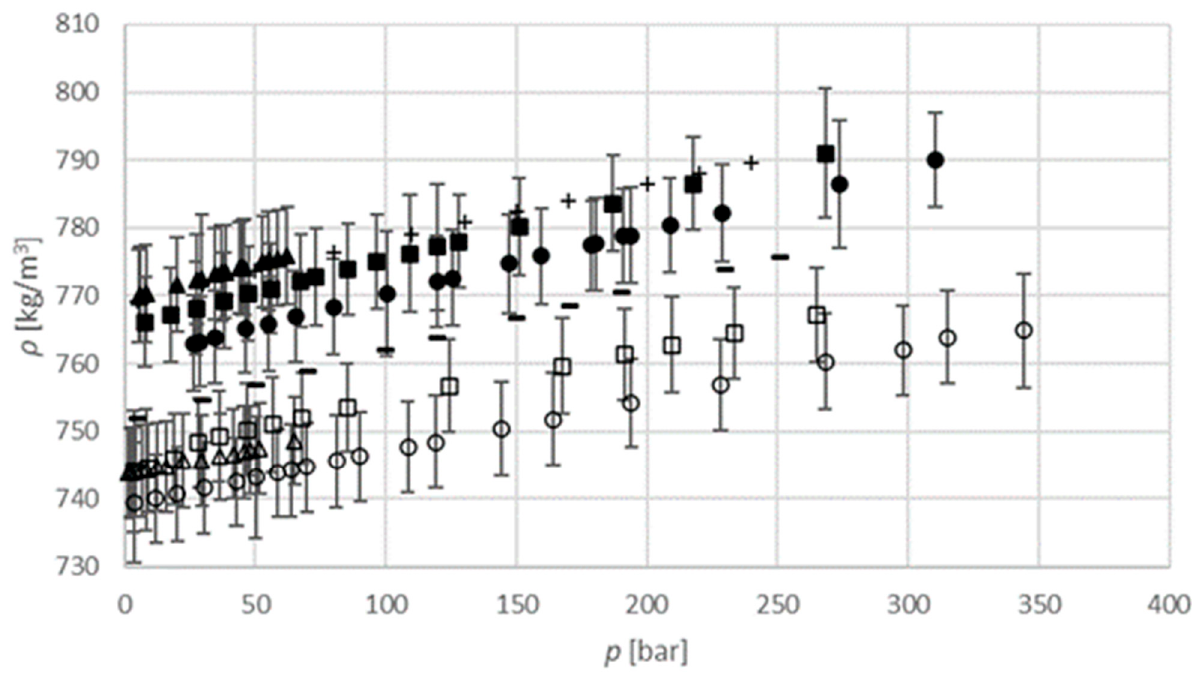
Figure 7. Densities: Figure 4. The viscosity of pure gas as a function of pressure in comparison to literature data: , , measured data CO 2 saturated isopropanol at 313.15 K; Figure 7. Densities: , measured data CO 2 saturated isopropanol at 313.15 K; , measured data , measured data CO 2 Figure 4. The viscosity of pure gas as a function of pressure in comparison to literature data: , Figure 7. Densities: , measured data CO 2 saturated isopropanol at 313.15 K; , measured data Figure 7. Densities: , measured data CO 2 saturated isopropanol at 313.15 K; , measured data measured data at 313.15 K; , measured data at 333.15 K; X, pure gas at 313.15 K [16]; , pure gas saturated isopropanol at 333.15 K; , argon saturated isopropanol at 313.15 K; , argon saturated CO 2 saturated isopropanol at 333.15 K; , argon saturated isopropanol at 313.15 K; , argon satu- measured data at 313.15 K; , measured data at 333.15 K; X, pure gas at 313.15 K [16]; , pure gas CO 2 saturated isopropanol at 333.15 K; , argon saturated isopropanol at 313.15 K; , argon satu- Figure 4. The viscosity of pure gas as a function of pressure in comparison to literature data: , Figure 5. Viscosity of the CO 2 -saturated isopropanol binary system: , measured data at 313.15 K; CO 2 saturated isopropanol at 333.15 K; , argon saturated isopropanol at 313.15 K; , argon satu- at 333.15 K [16]. rated isopropanol at 333.15 K; , SF 6 saturated isopropanol at 313.15 K; , SF 6 saturated isopropa- at 333.15 K [16]. isopropanol at 333.15 K; rated isopropanol at 333.15 K; , SF 6 saturated isopropanol at 313.15 K; , SF 6 saturated isopropa- measured data at 313.15 K; , measured data at 333.15 K; X, pure gas at 313.15 K [16]; , pure gas , measured data at 333.15 K. , SF 6 saturated isopropanol at 313.15 K; rated isopropanol at 333.15 K; , SF 6 saturated isopropanol at 313.15 K; , SF 6 saturated isopropa- nol at 333.15 K; X, Zúñiga-Moreno, et al. (2002) isopropanol at 313.15 K [26]; –, Zúñiga-Moreno et al. nol at 333.15 K; X, Zúñiga-Moreno, et al. (2002) isopropanol at 313.15 K [26]; –, Zúñiga-Moreno et al. at 333.15 K nol at 333.15 K; X, Zúñiga-Moreno, et al. (2002) isopropanol at 313.15 K [26]; –, Zúñiga-Moreno et al. (2002) isopropanol at 332.99 K [26]. (2002) isopropanol at 332.99 K [26]. (2002) isopropanol at 332.99 K [26].